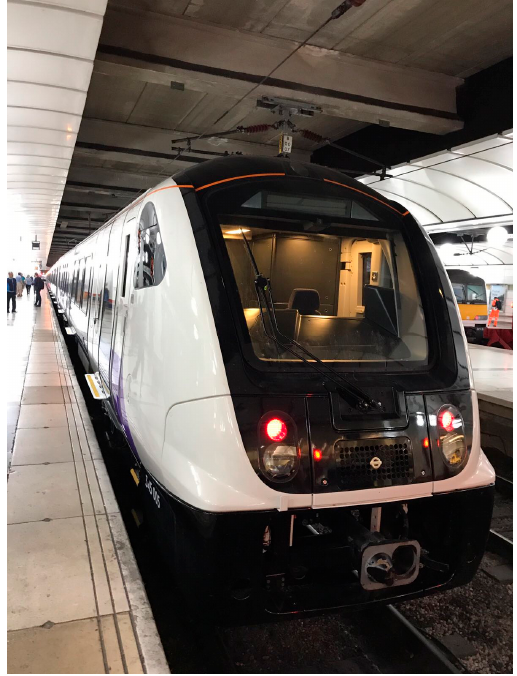
Figure 6. New train with aluminum train compartment.